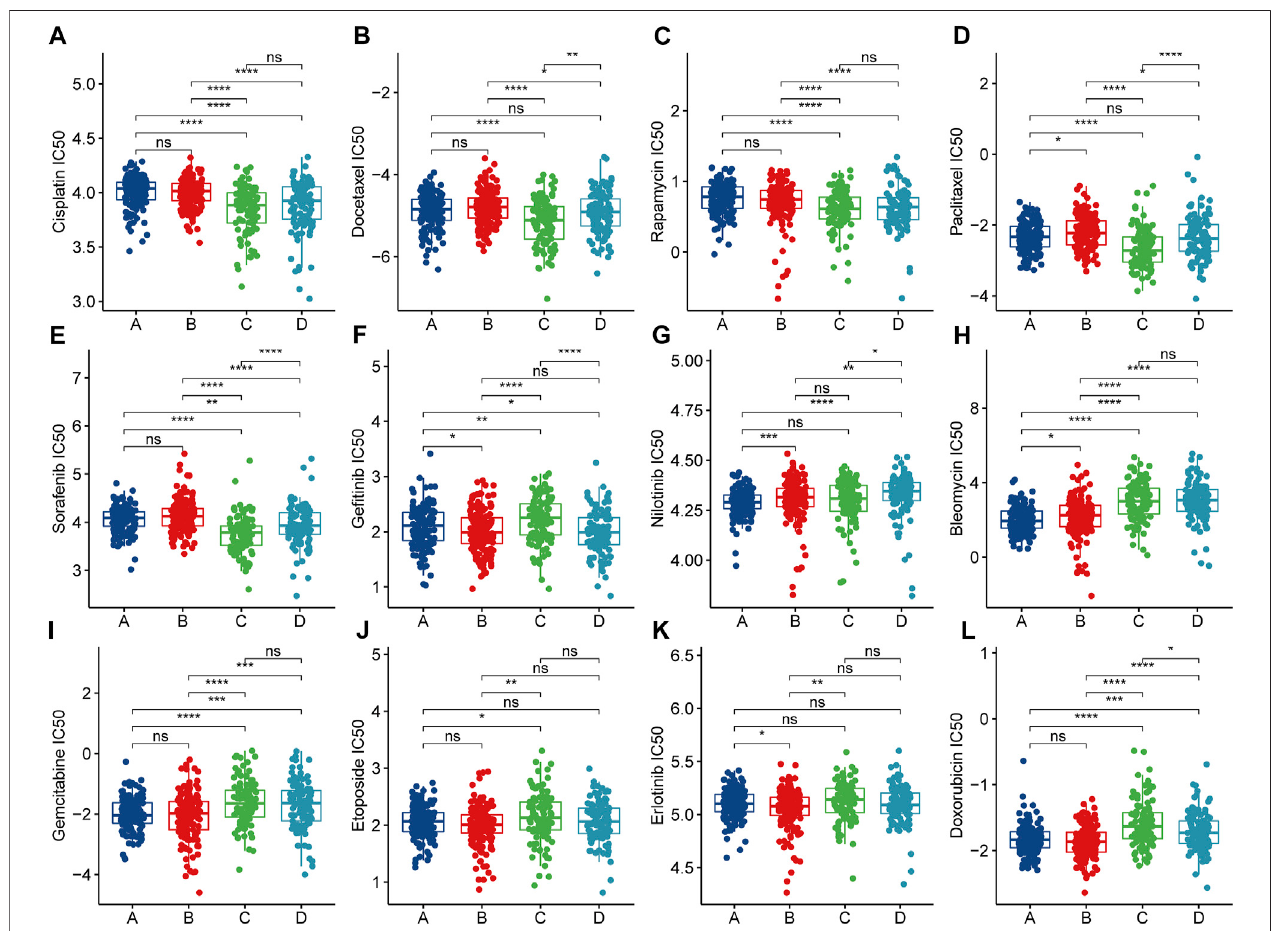
FIGURE8| AnticancerDrugSensitivityAnalysisinPatientswithDifferentClusters. (A – L) Halfmaximalinhibitoryconcentration(IC50)ofmultipleanticancerdrugsin patients with different clusters.